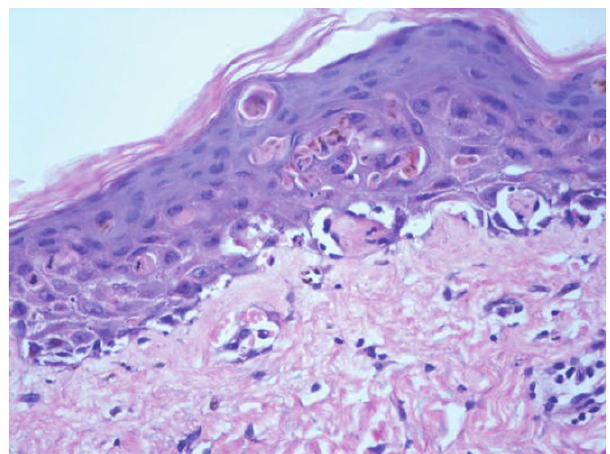
Figure 2 - Skin biopsy stained with hematoxylin–eosin at 6 20 magnification, showing the epidermis with basal cell hydropic